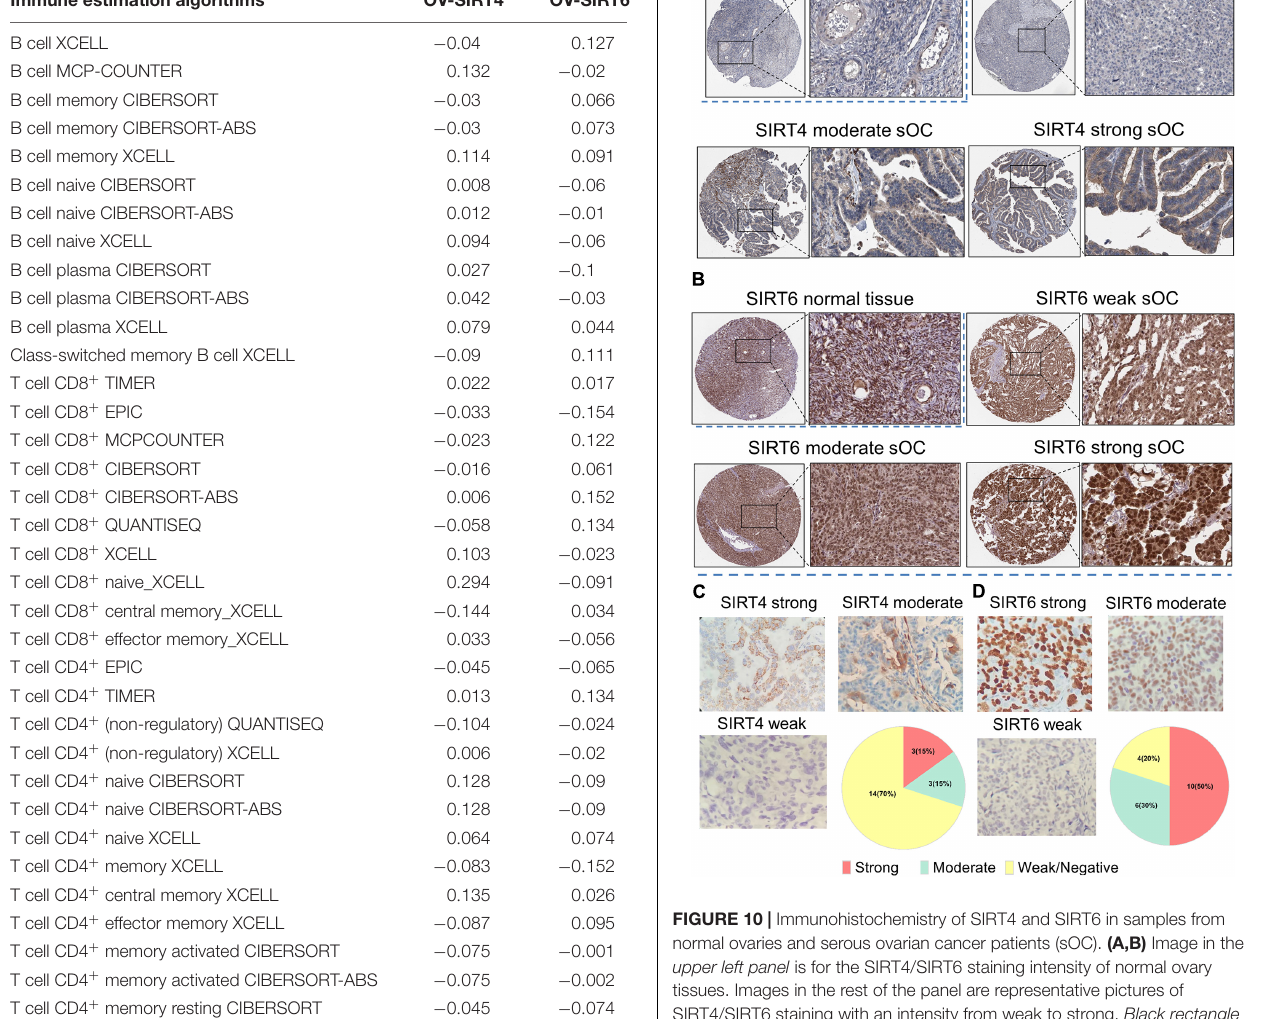
TABLE 3 | Immune cell infiltration analyses with the TIMER2.0 estimation model. Immune estimation algorithms